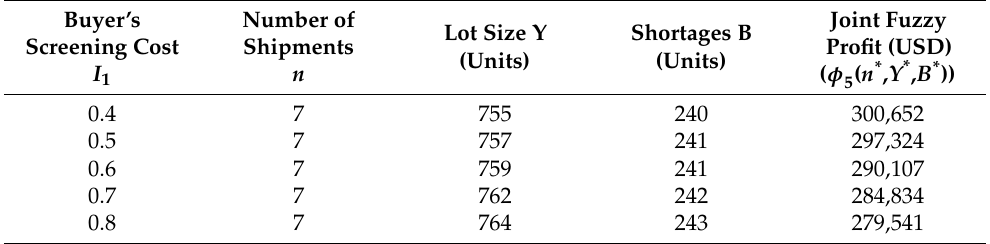
Table 21. Impact of the buyer’s screening cost on the decision variables and joint fuzzy profit.